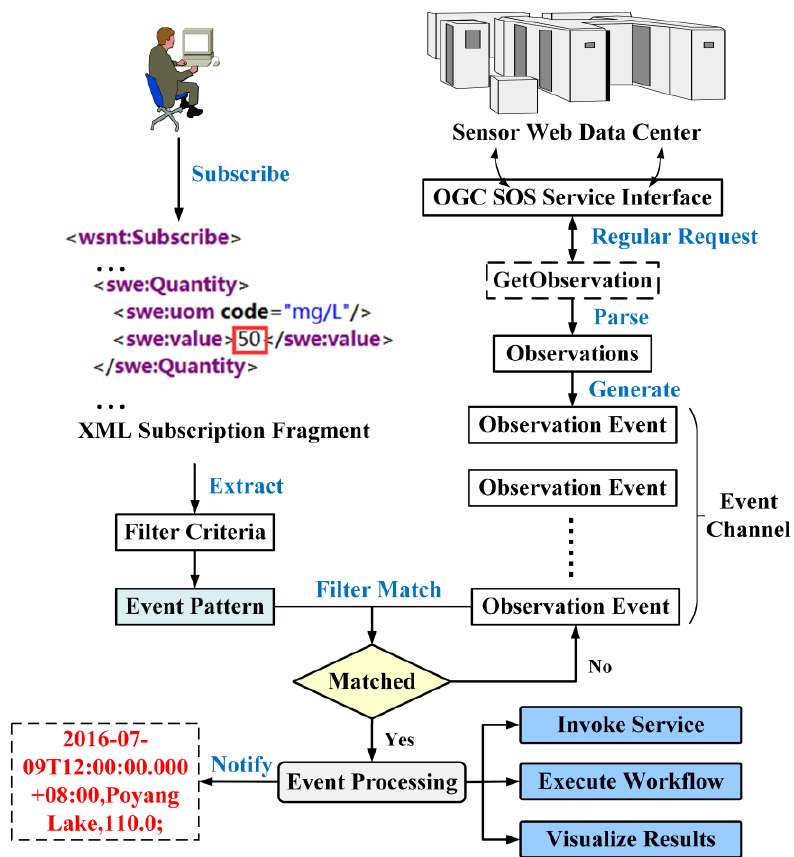
Figure 2. The event processing flow in an event-driven mechanism for hydrological disaster monitoring.